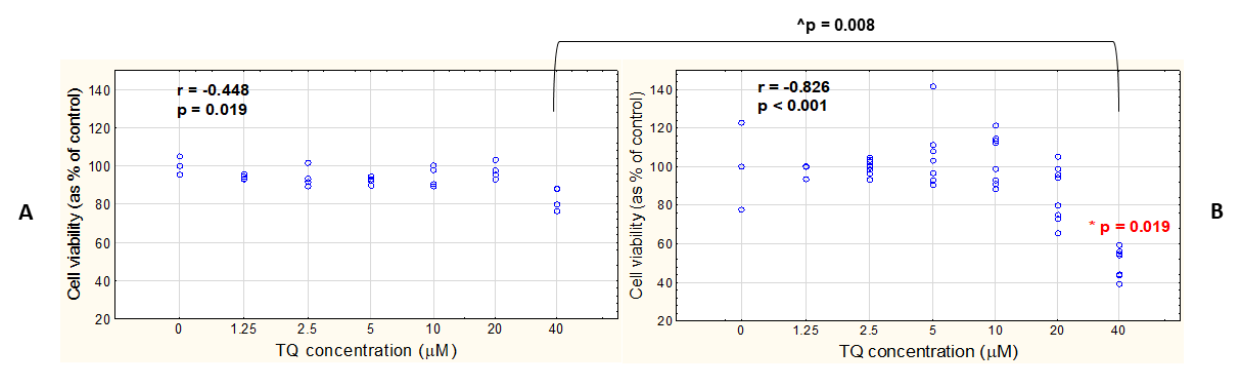
Figure 7. WM9 cells show higher sensitivity to antiproliferative effect of TQ. Assessment of cytotoxicity (WST-1) in the two melanoma cell lines: A375 ( A ) and WM9 ( B ) treated with different concentrations of free TQ for 48 h. Spearman correlation analysis of the data shows the relationship between TQ concentration and cell viability. Spearman correlation coefficient (r) and p -value are shown; * denotes significant differences between the TQ-treated cells and DMSO control (presented as o µ M TQ concentration) (Mann–Whitney U test); ˆ denotes significant differences between the two analyzed cell lines (Mann–Whitney U test); data are presented as mean ± SD; all the results were considered statistically significant when p < 0.05.